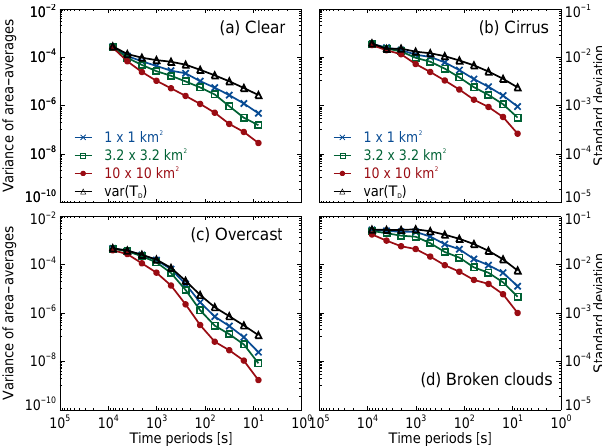
Figure 8. Power spectrum of spatially averaged transmittance as a function of frequency under different sky conditions: (a) clear, (b) cirrus, (c) overcast, and (d) broken clouds; var (T D ) denotes the power spectrum of a point measurement of global transmittance as shown in Fig.